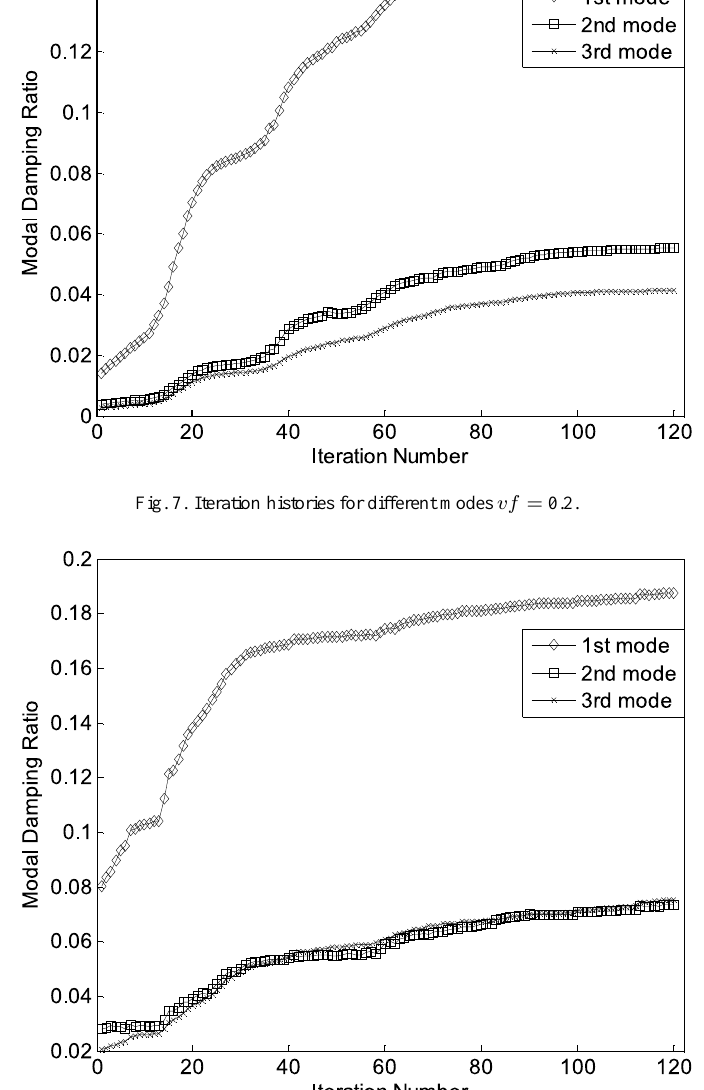
Fig. 8. Iteration histories for different modes vf =